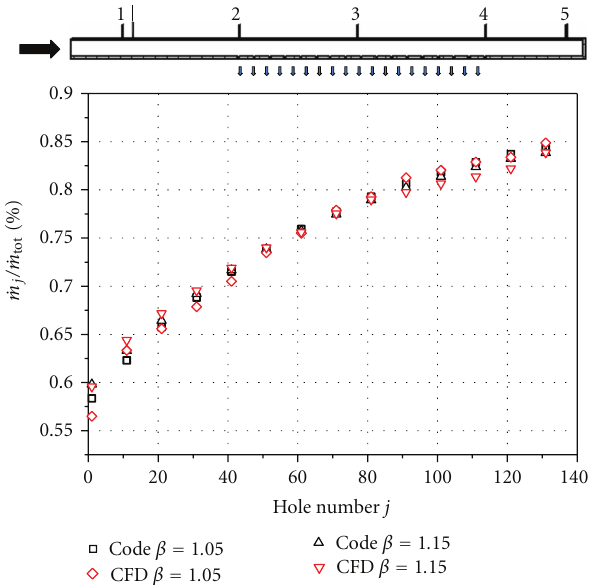
Figure 9: Mass flow split distribution for Geom 2 (percent).